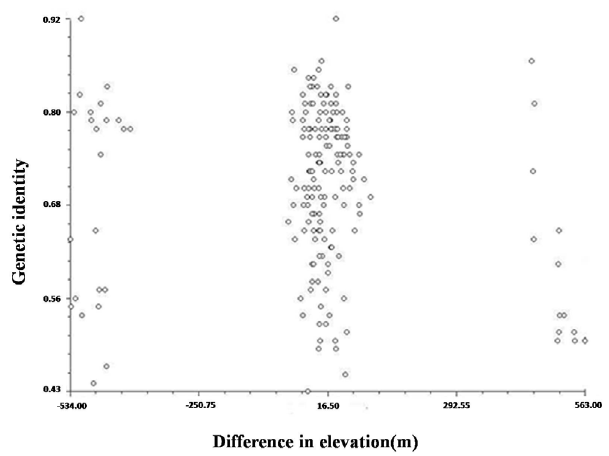
Fig 4 . Correlation between genetic identity and difference in elevation. The data points were generated by MXCOMP programs and shown as a scattered pattern. No significant correlation were identified between genetic similarity and sample elevation by Mantel test ( r = −0.12512, p =